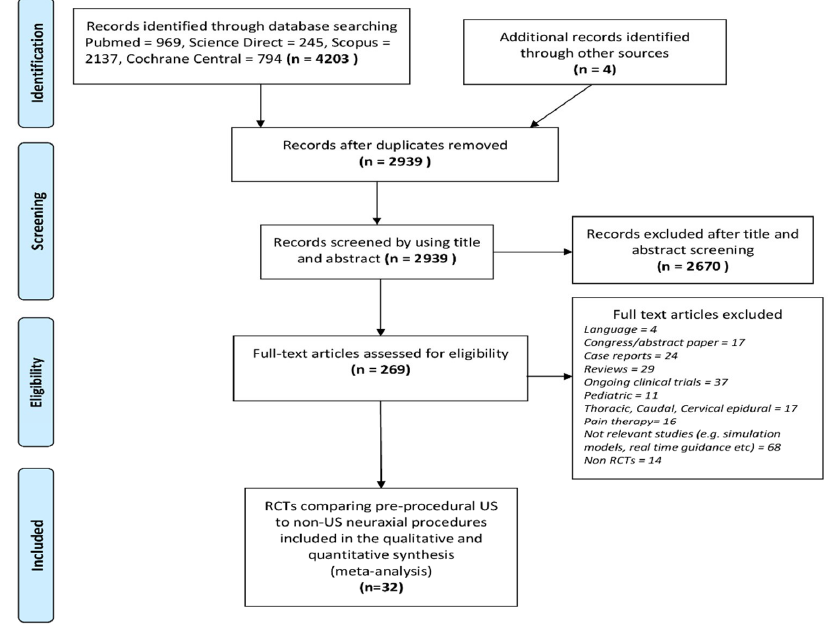
Figure 1. PRISMA flow diagram of this systematic review.